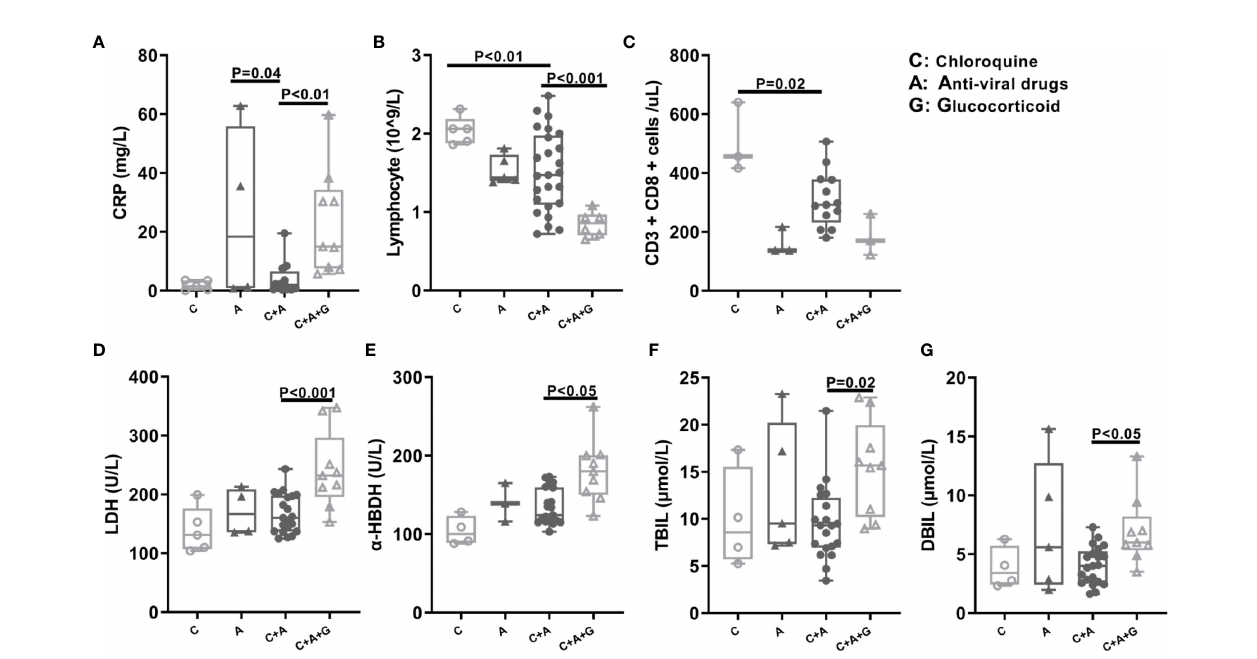
FIGURE 6 | The Difference of Patients ’ Clinical Indicators after Chloroquine, Anti-viral Drug or Glucocorticoid Medication. The patients were grouped in chloroquine group, antiviral drug group, chloroquine plus antiviral drugs, chloroquine, antiviral drugs plus glucocorticoids group. Several clinical indicators like CRP (A) , lymphocyte (B) , CD3+CD8+ cells (C) , LDH (D) , a -HBDH (E) , TBIL (F) , DBIL (G) collected between 8-21 days from symptom onset were analyzed. a -HBDH, a - Hydroxybutyrate dehydrogenase; CRP, C-reaction protein; LDH, Lactate dehydrogenase; TBIL, Total bilirubin; DBIL, Direct bilirubin; C, Chloroquine; A, Anti-viral Drug; G,